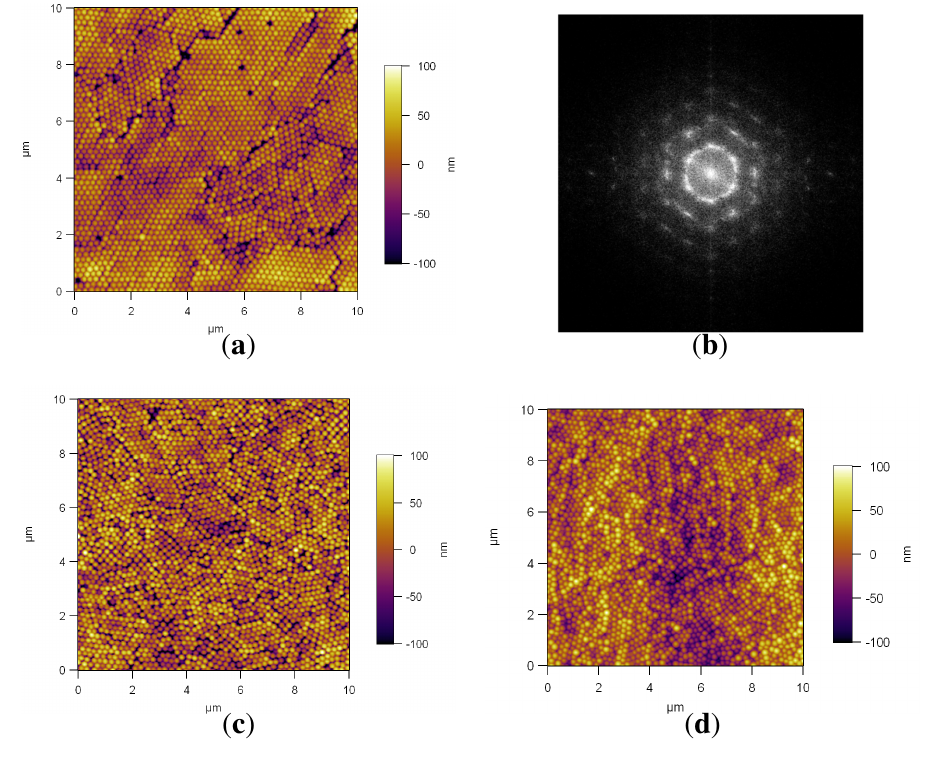
Figure 7. AFM height profiles of PS NP self-assembly by spin coating at 300 rpm, on, Si/PEI/(PSS/PAH) ( a ), with the corresponding FFT spectrum of the image ( b ); on 2 PDMAEMA brushes ( c ); on quaternized PDMAEMA brushes ( d ).